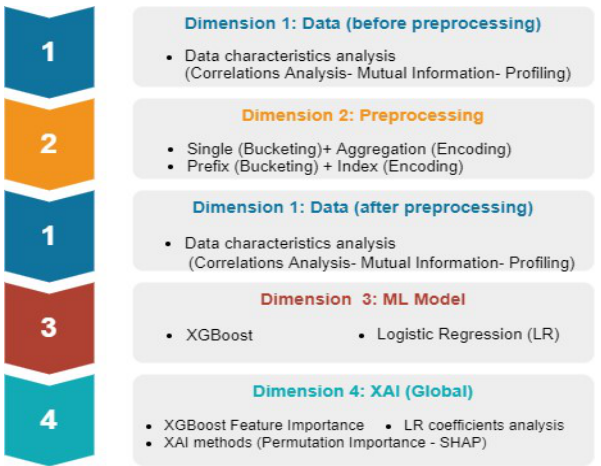
Figure 3. Experimental